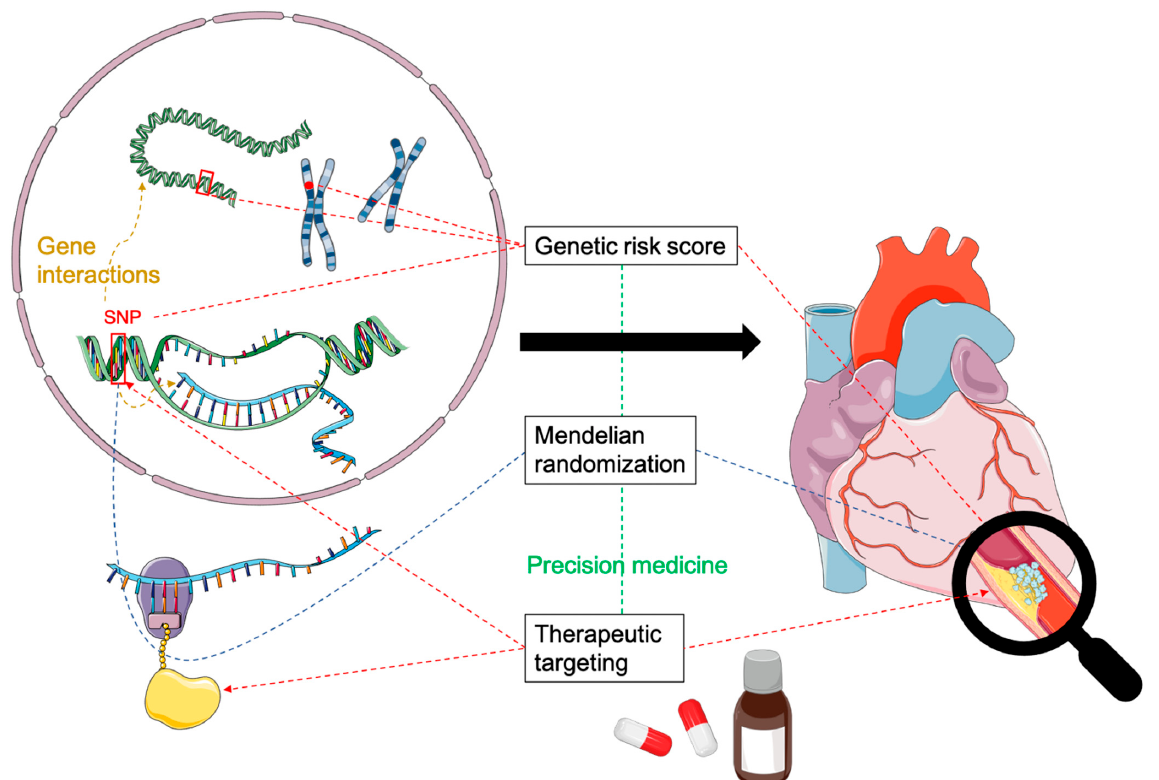
Figure 1. Simplified representation of the potential influence results from genome-wide significant association studies (GWAS) may have on clinical perspectives in coronary artery disease. For details, please refer to the text. Contains modified images from Servier Medical Art under a Creative Commons Attribution 3.0 Unported License.